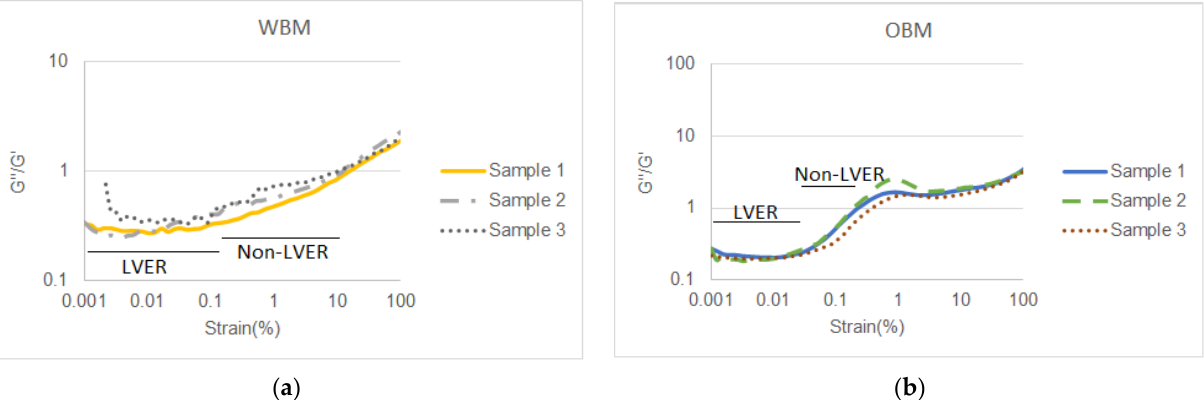
Figure 3. The ratio between the loss modulus (G”)/storage modulus (G ′ ) of the cuttings bed with ( a ) water-based (WBM) and ( b ) oil-based (OBM) as the interstitial fluids. LVER: linear viscoelastic region.